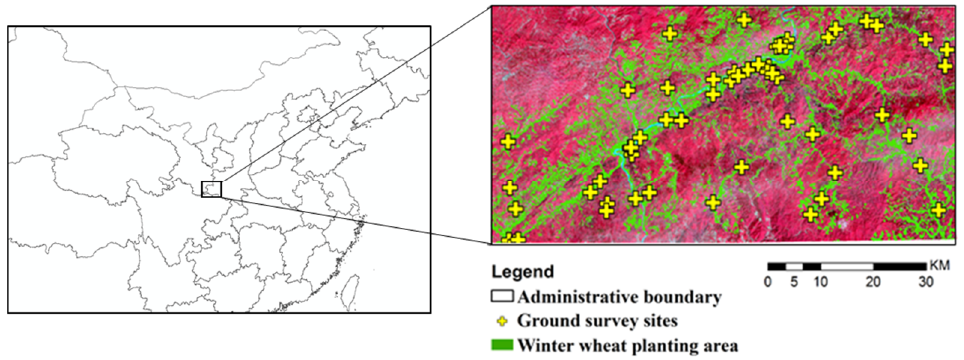
Figure 6. A false color map of the research area and survey area of Ningqiang, Shaanxi Province; the wheat planting area is shown in green, and the sampling points are marked yellow .